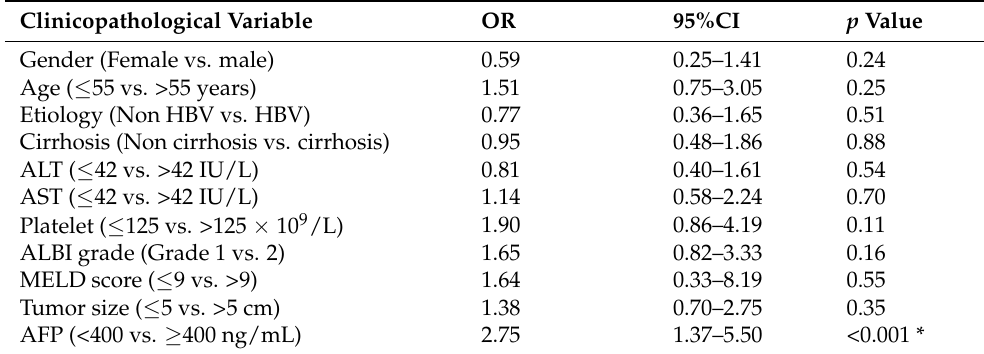
Table 2. Univariable regression analysis of the clinicopathological variables associating with histopathologic grading of HCC in the development